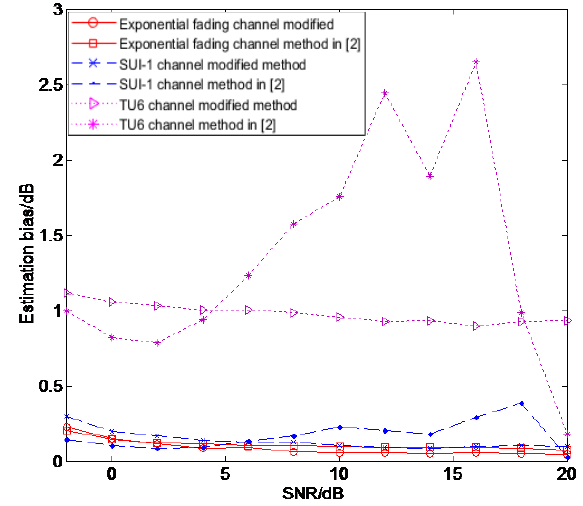
Figure 8. Comparison of different SNR estimation